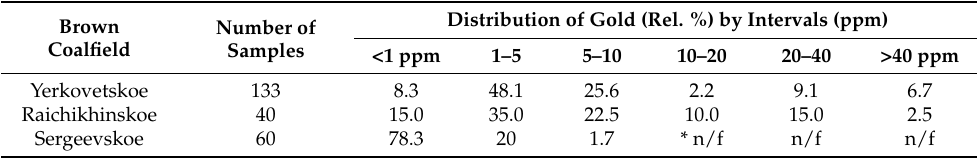
Table 4. Relative abundance of gold in brown coals of Zeya–Bureya Basin